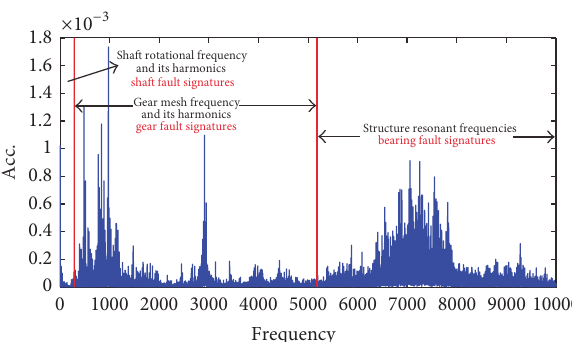
Figure 12: The vibration spectrum of the raw measured signal picked by the fixed accelerometer mounted on the annulus gear.